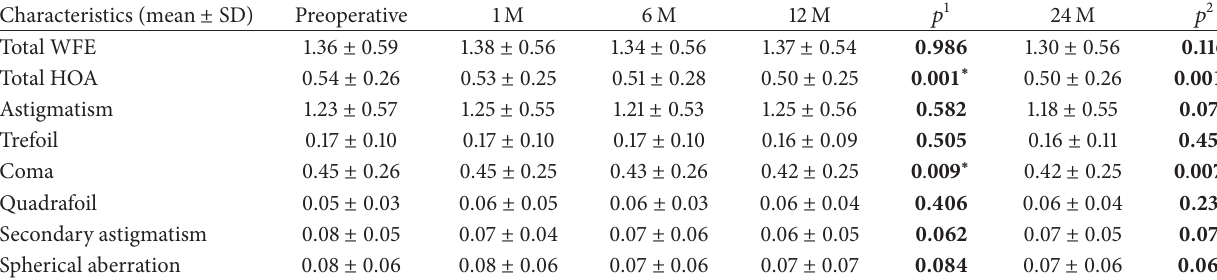
Table 2: Corneal wavefront aberrations before and 1, 6, 12, and 24 months after accelerated corneal cross-linking. Characteristics (mean ±